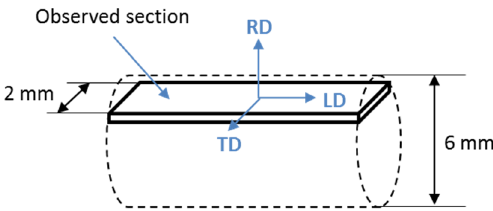
Figure 1. Schematic of the lamella sampling inside the gauge length of a torsion test sample. After cutting, the thickness is in the range of a millimeter; the thickness is then decreased to 300 µ m by mechanical polishing.